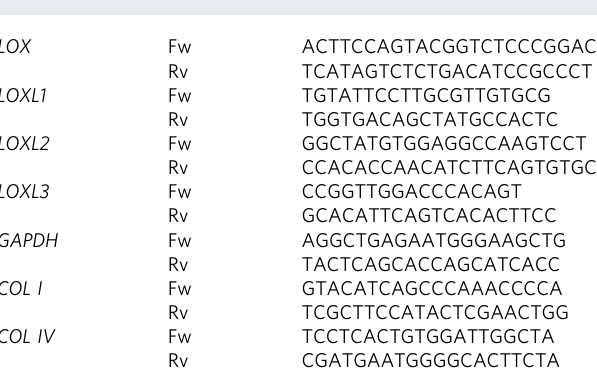
Table 2 List of qPCR